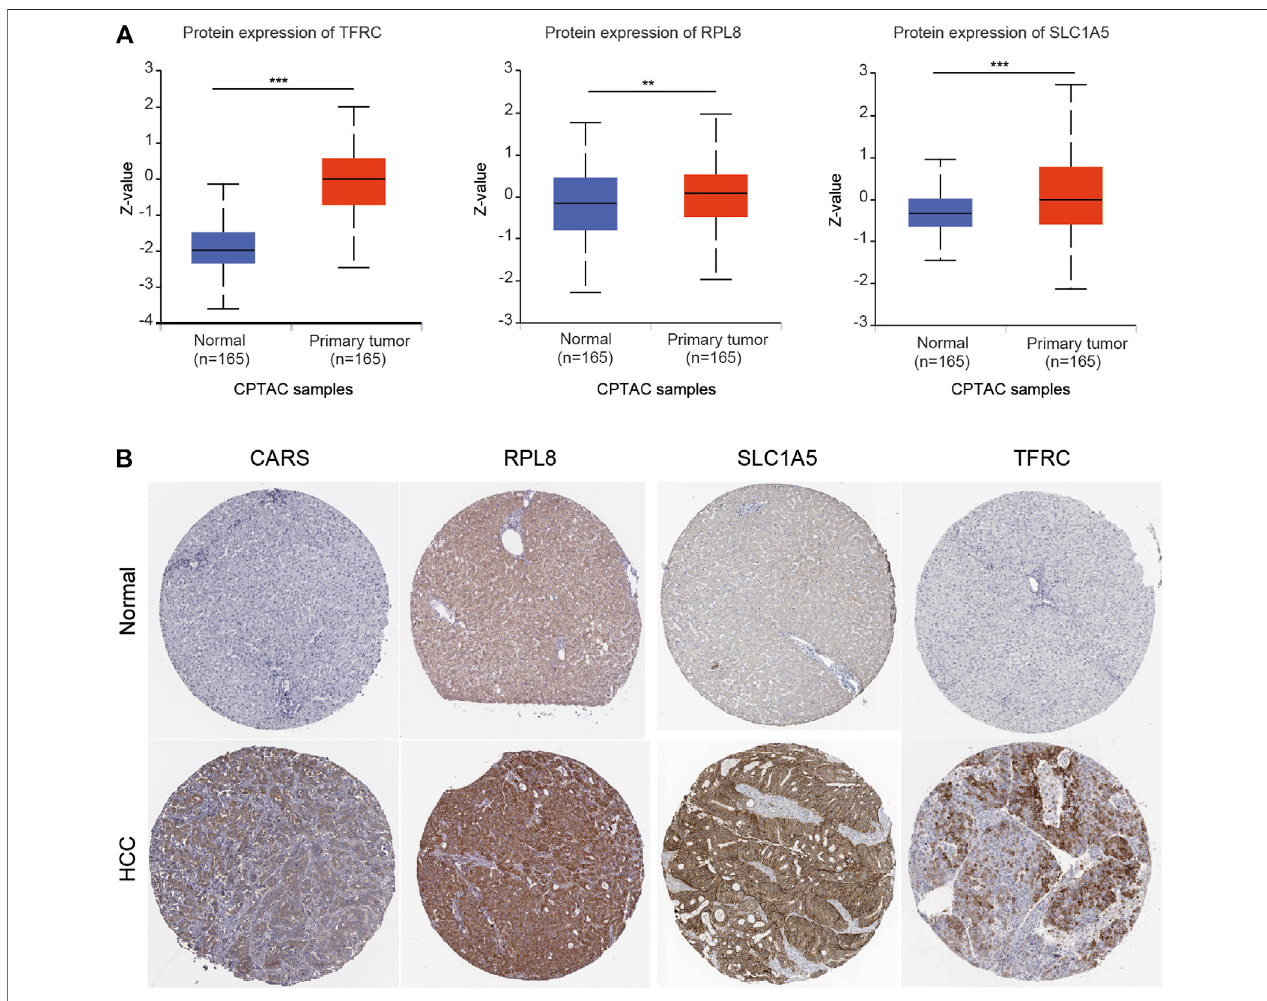
FIGURE 7 | Higher protein expression of FRGs in HCC tissues than in normal liver tissues. (A) The protein expression of TFRC, RPL8 and SLC1A5 in HCC tissues and normal tissues was investigated in the CPTAC database. Z-values represent standard deviations from the median across samples for HCC. (B) Immunohistochemistry analysis was used to examine the protein expression levels of SLC1A5, TFRC, RPL8 and CARS1 in the HPA database. * p < 0.05, ** p < 0.01, *** p < 0.001.